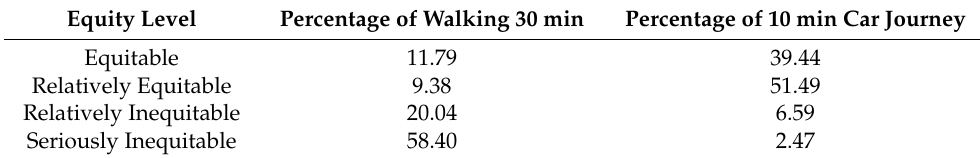
Table 5. Equity level statistics for residential units with walking 30 min and driving 10 min by car.